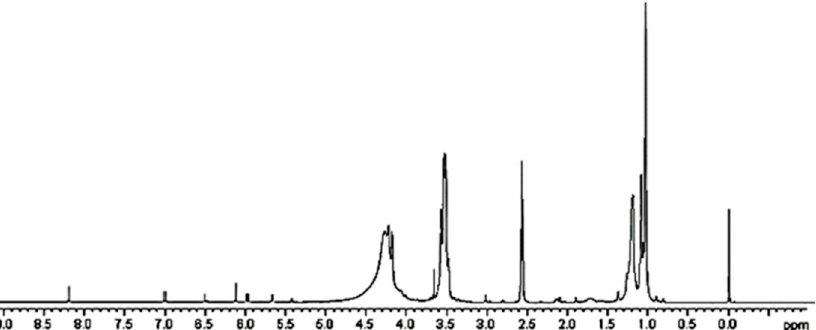
Figure 5. 1 H NMR of CPX 5 (DMSO-d6, 300 MHz).